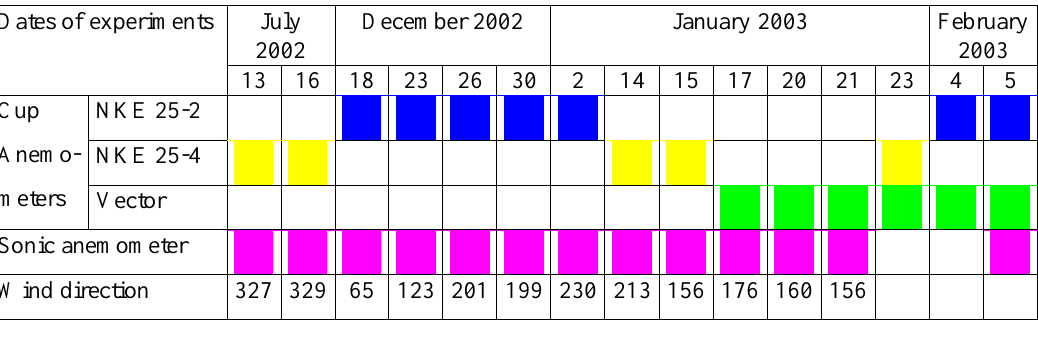
Table 1. Different periods of the experiment with the relating mean wind directions and sensors used.